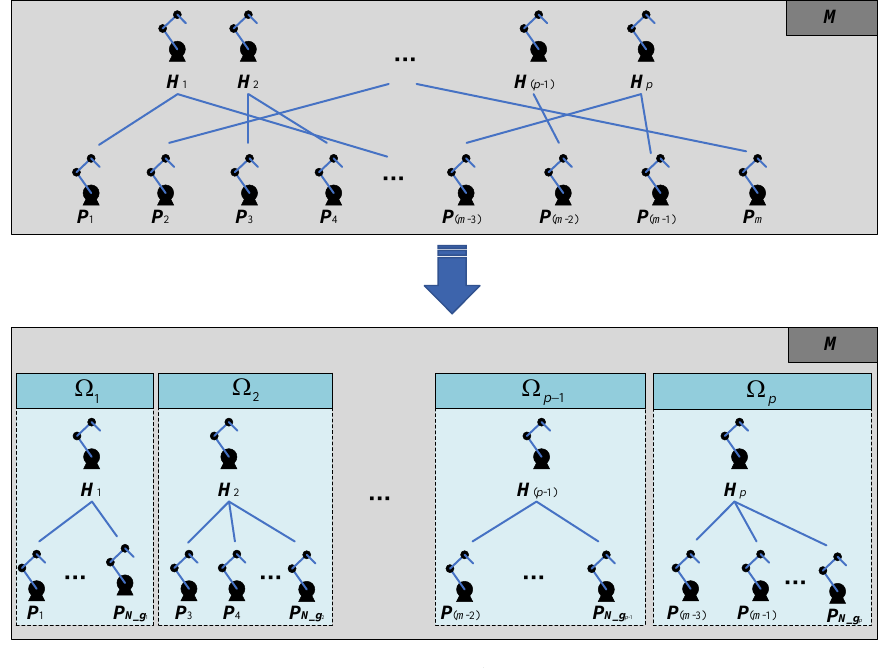
Figure 1. Diagram of problem transformation. denotes a configuration of the manipulator. The blue line indicates that there are possible collision-free paths between two configurations.